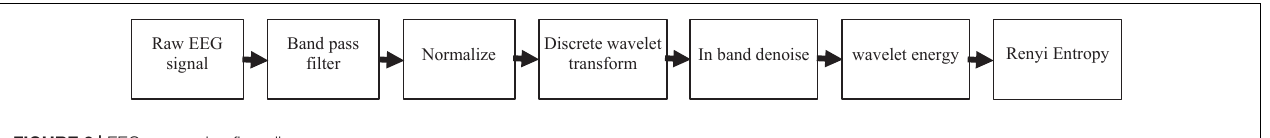
level four is approximately corresponding to the β , α , θ , and δ band of the EEG